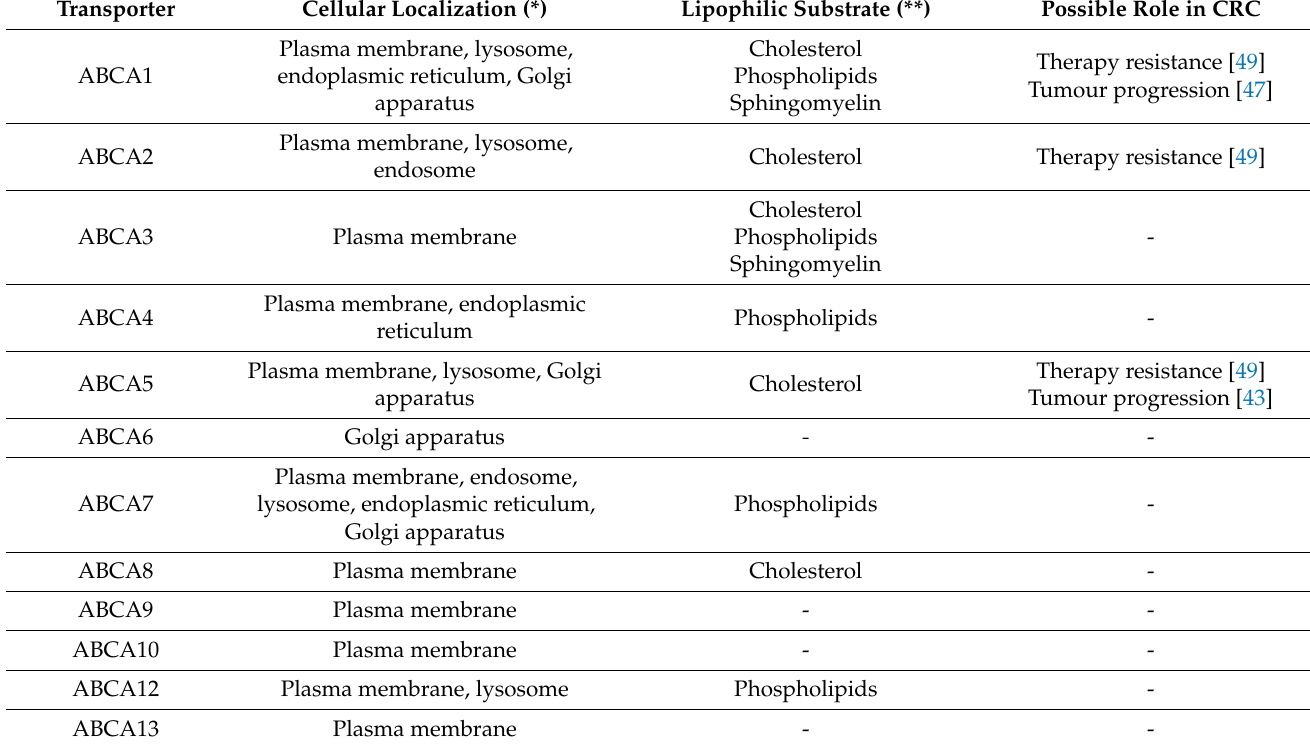
Table 1. Human ABC superfamily A transporter, their cellular localization, lipophilic substrate and possible role in colorectal cancer. (*) uniport database/www.uniprot.org, accessed on 11 December 2022 [33]; (**) https://doi.org/10.1016/j.bbamem.2016.09.023, accessed on 11 December 2022